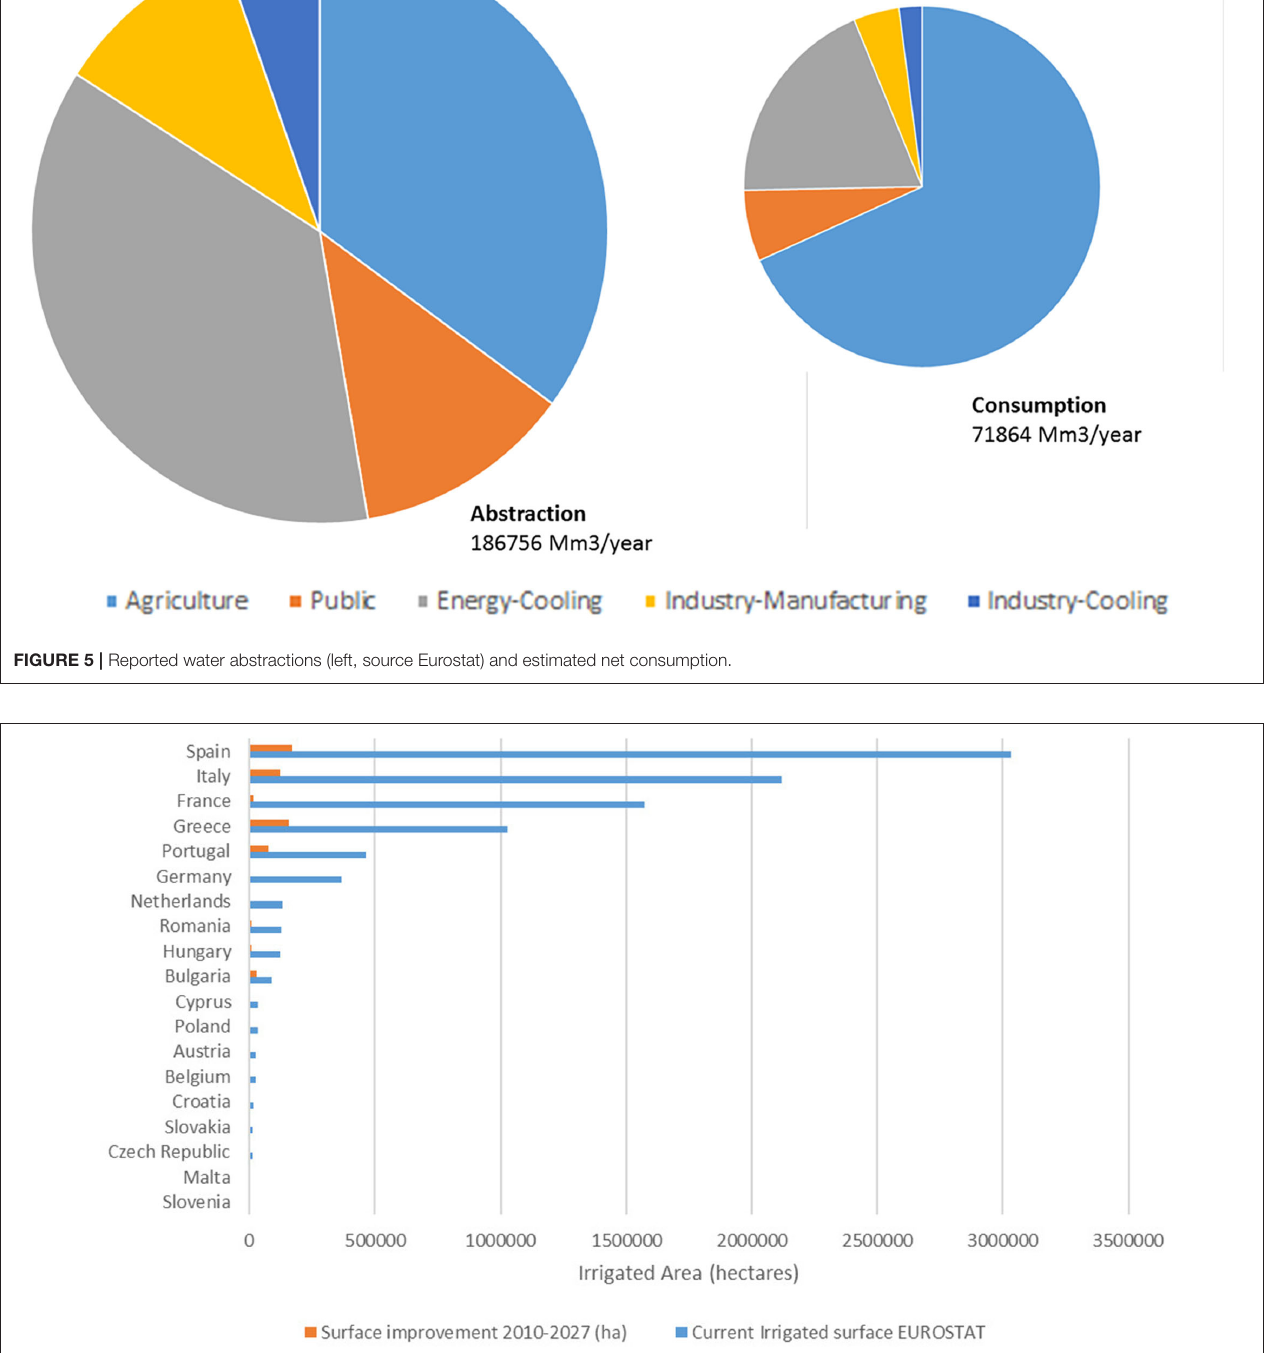
in irrigation efficiency up to 2030. We have implemented these changes as shifts from sprinkling irrigation toward drip